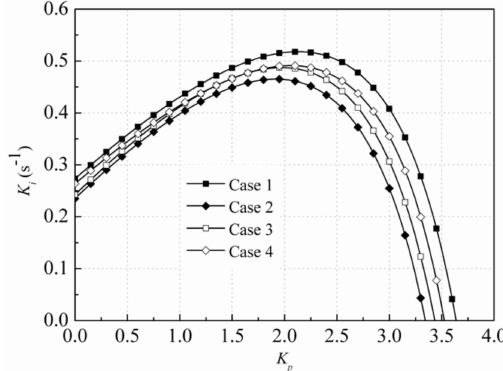
Figure 23. Stable domains of HTGSes with SCTTs under di ff erent operating conditions and layouts